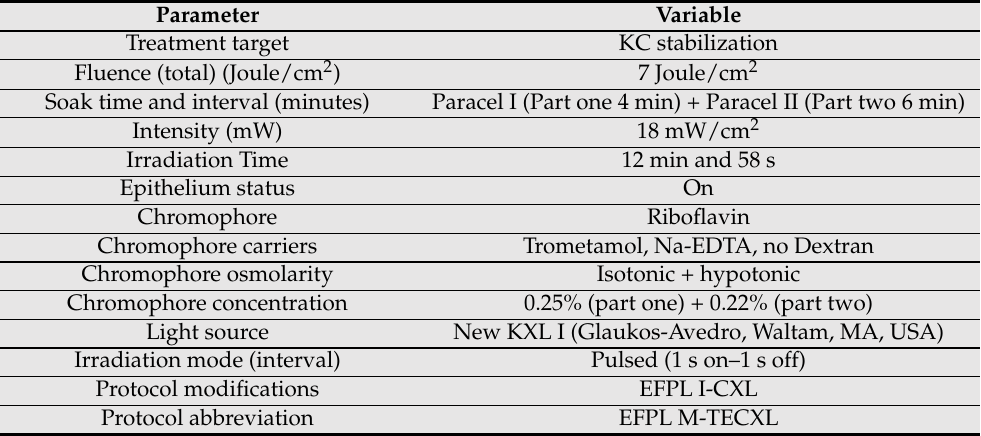
Table 1. Enhanced fluence pulsed light M Epi-on crosslinking protocol (EFPL-M-TECXL).